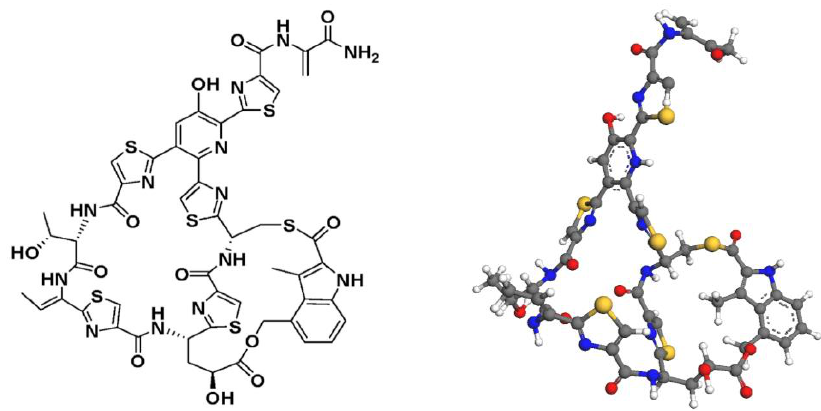
Figure 1. Nosiheptide molecular structure skeletal (left) + 3D (right) structures [9].